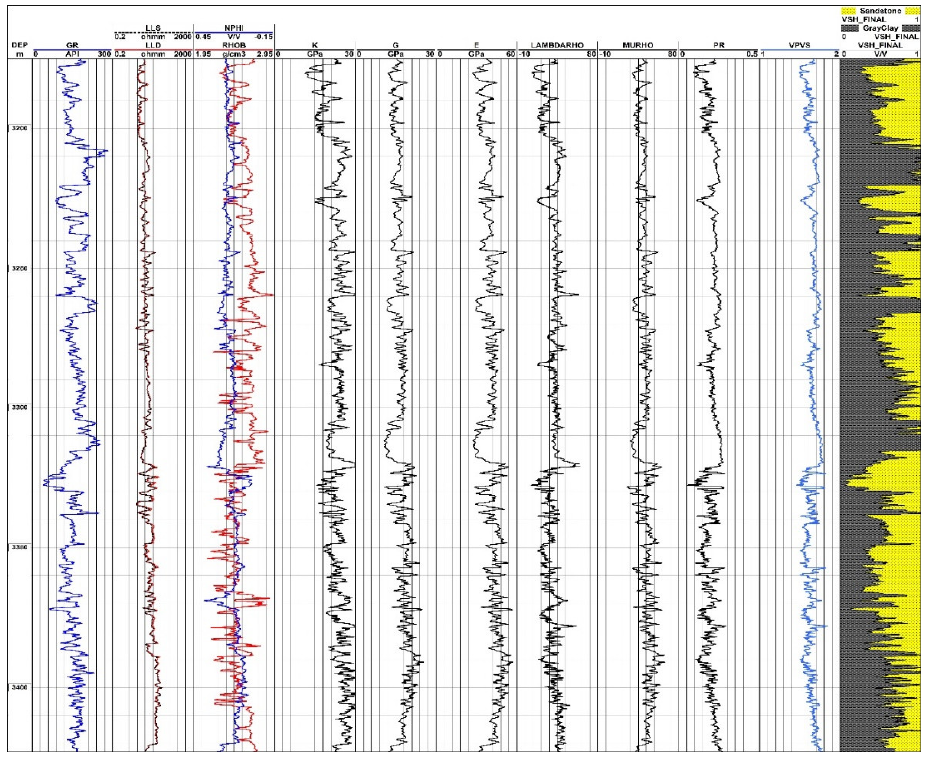
Figure 15. Standard petrophysical logs (tracks-2–4), mechanical properties (tracks-5–9), and elas- tic/seismic logs (tracks-10–11) provide a reliable and consistent interpretation of lithology (track-12) of Miano-07.